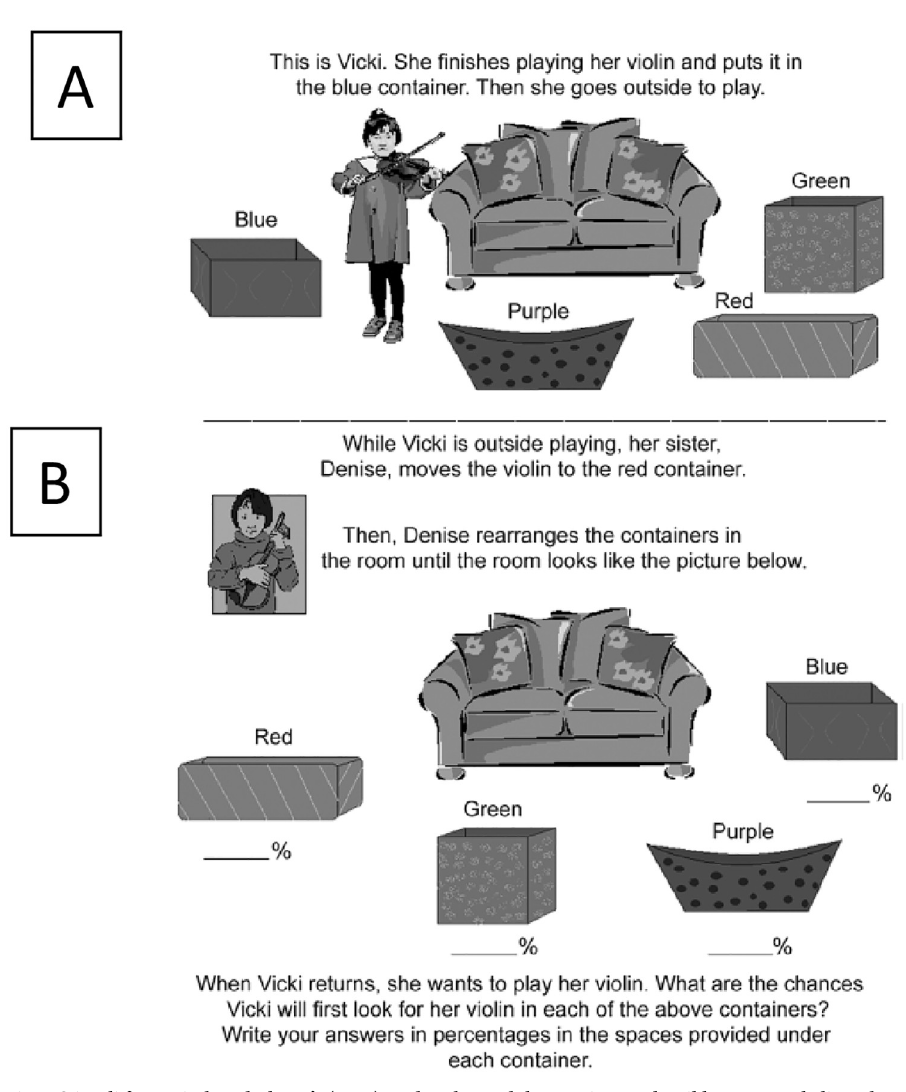
Fig 1. Stimuli from Birch and Bloom’s (2007) study, where adults are given a plausible reason to believe that Vicki would look for her violin in the current container. Note, that the red container (current container) in section B is in the same spot as the blue container (original container) in section A. From “The Curse of Knowledge in Reasoning About False Beliefs” by Birch & Bloom (2007), Psychological Science , 18 (5), 384. violin was moved (e.g., red container), and others were simply told that it was moved to a dif- ferent container, with no specific information as to where. Participants who knew it had been moved to the red container were significantly worse at predicting Vicky’s false belief than par- ticipants who did not know where the object had been moved. That is, adults who can unquestionably reason about false beliefs can be biased, or ‘cursed’ so-to-speak, by their own knowledge when reasoning about false beliefs [for replications and extensions of this work, see 83, 84]. It might be tempting to attribute the curse of knowledge to poor inhibitory control, where an individual is biased by their knowledge because they are unable to inhibit the con- tents of their own knowledge. While there is evidence for the role of inhibitory control on the curse of knowledge [81, 85, 86], inhibitory control does not fully account for the curse of knowledge [87–89]—a point we return to in greater detail in the Discussion.